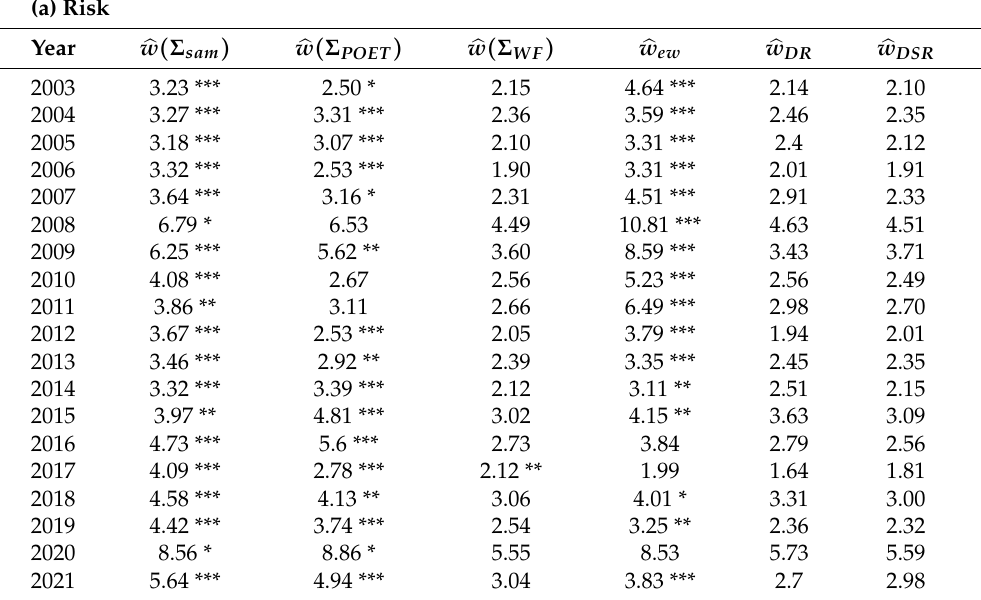
Table 4. Performance of various MVP estimators using empirical